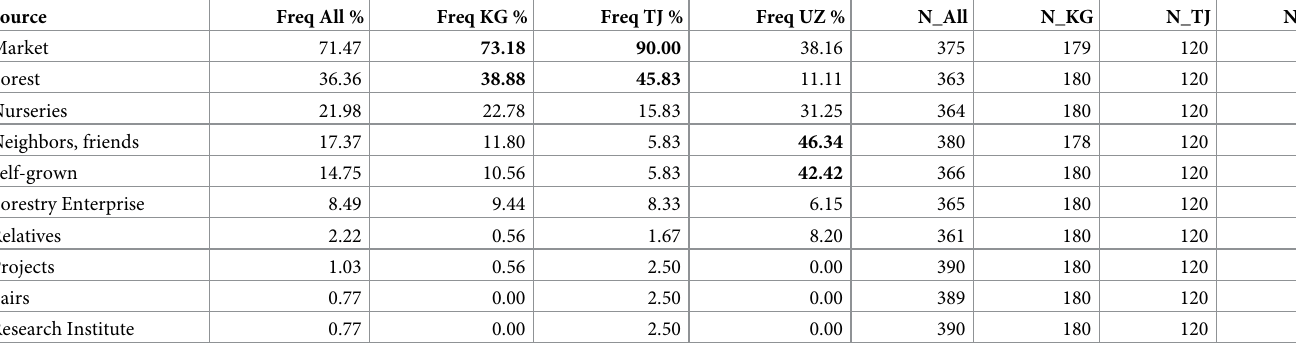
Note: Frequencies represent the proportion (%) of respondents per country who cited the given source of planting material. Open ended question and multiple responses (sources) per interviewee possible, hence frequencies add up to more than 100% per country. Total number of respondents reported in the last four columns. KG: Kyrgyzstan, TJ: Tajikistan, UZ: